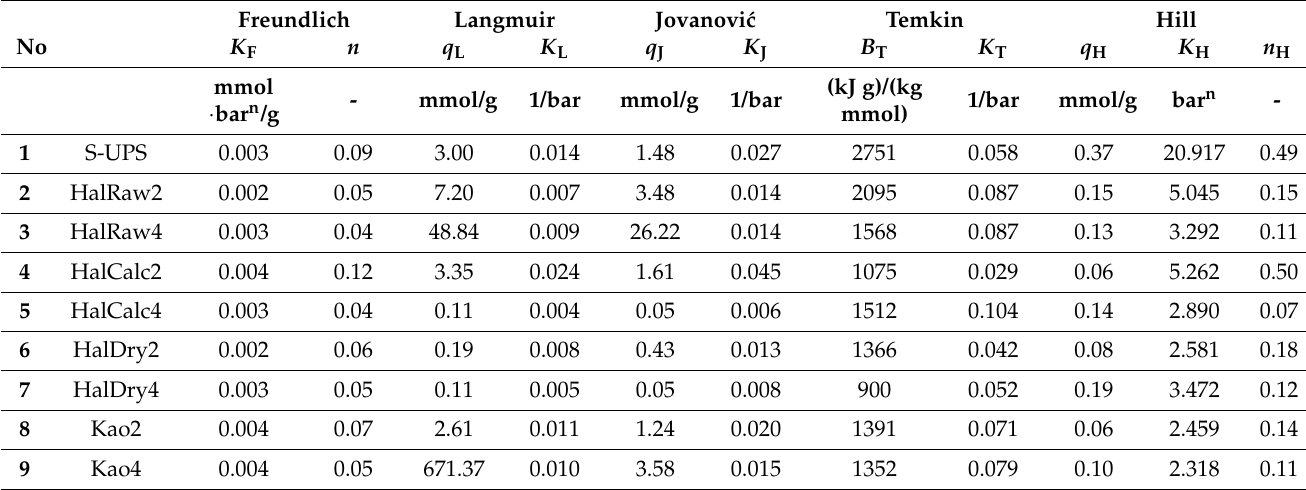
Table 4. The values of standard deviation in respect to each adsorption isotherm (model) parameter according to the Freundlich, Langmuir, Jovanovi´c, Temkin and Hill adsorption isotherm models (statistical data derived from CAVS software [69]).